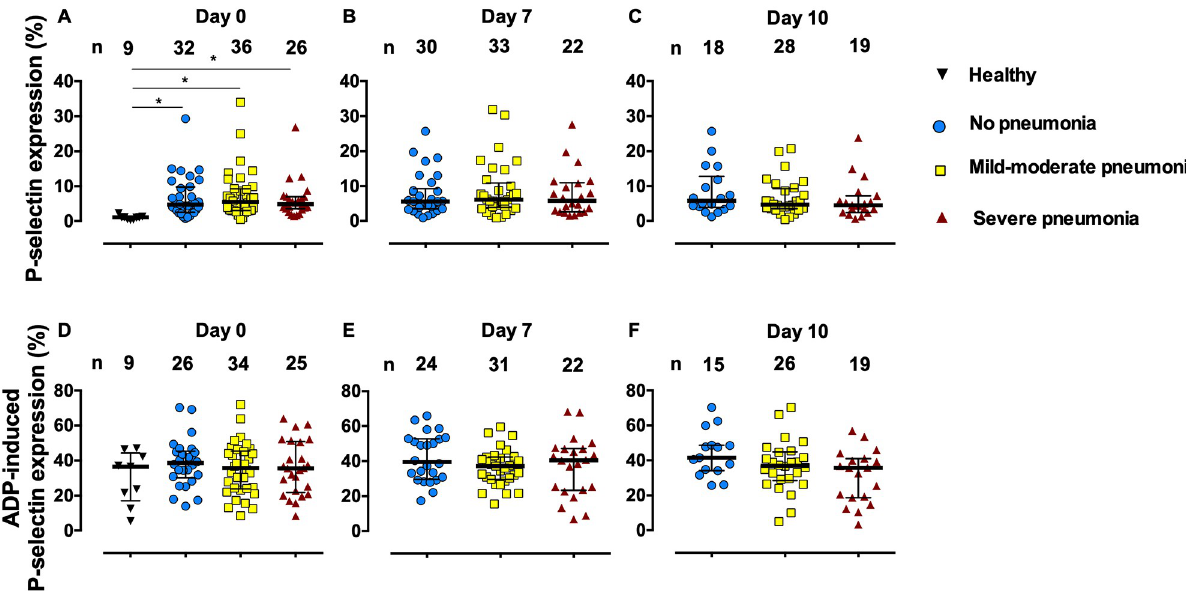
Fig 1. The P-selectin expression on platelets without (A-C) and with 1 μ M ADP stimulation (D-F) in healthy control subjects and COVID-19 patients on admission days 0, 7, and 10. Lines represent medians and interquartile ranges.